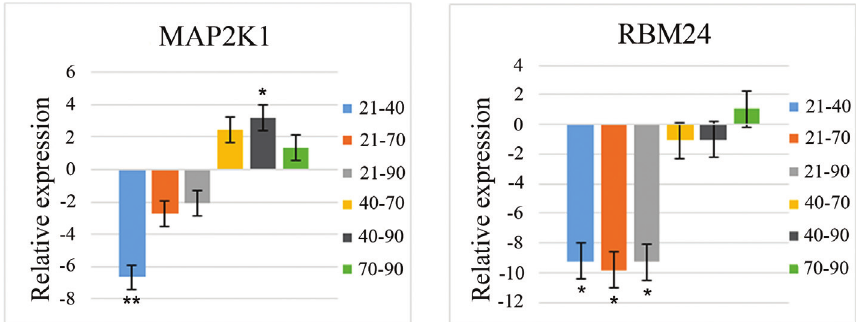
Figure 2 - Relative expression levels for two genes (MAP2K1 and RMB24) in pair-wise comparisons of prenatal ages (21, 40, 70 and 90 days post-insemination). These genes differed significantly in relation to the factor `Period’ (p < 0.05, F-test in ANOVA), but showed no significant difference for the interaction ‘Breed x Period’. *p < 0.05 and **p < 0.01 indicates significant pair-wise comparisons by Student’s t -test. A positive fold-change meansthatthefirstperiodinthecomparisonshowsgreaterexpressionthanthesecondperiod.Negativefold-changemeansthatthesecondperiodincom- parison presents greater expression than the first